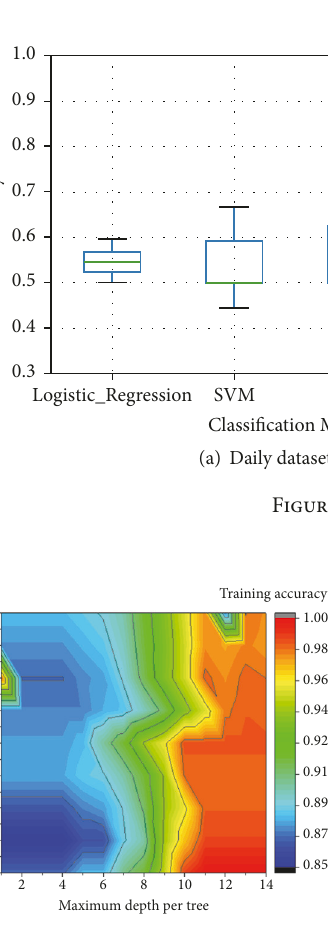
Figure 7: Sensitivity analysis for random forest method for hourly